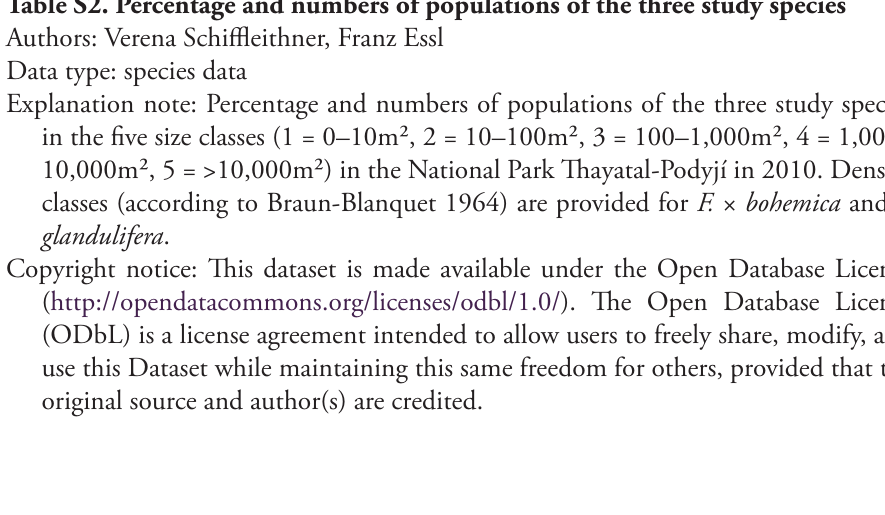
Table S2. Percentage and numbers of populations of the three study